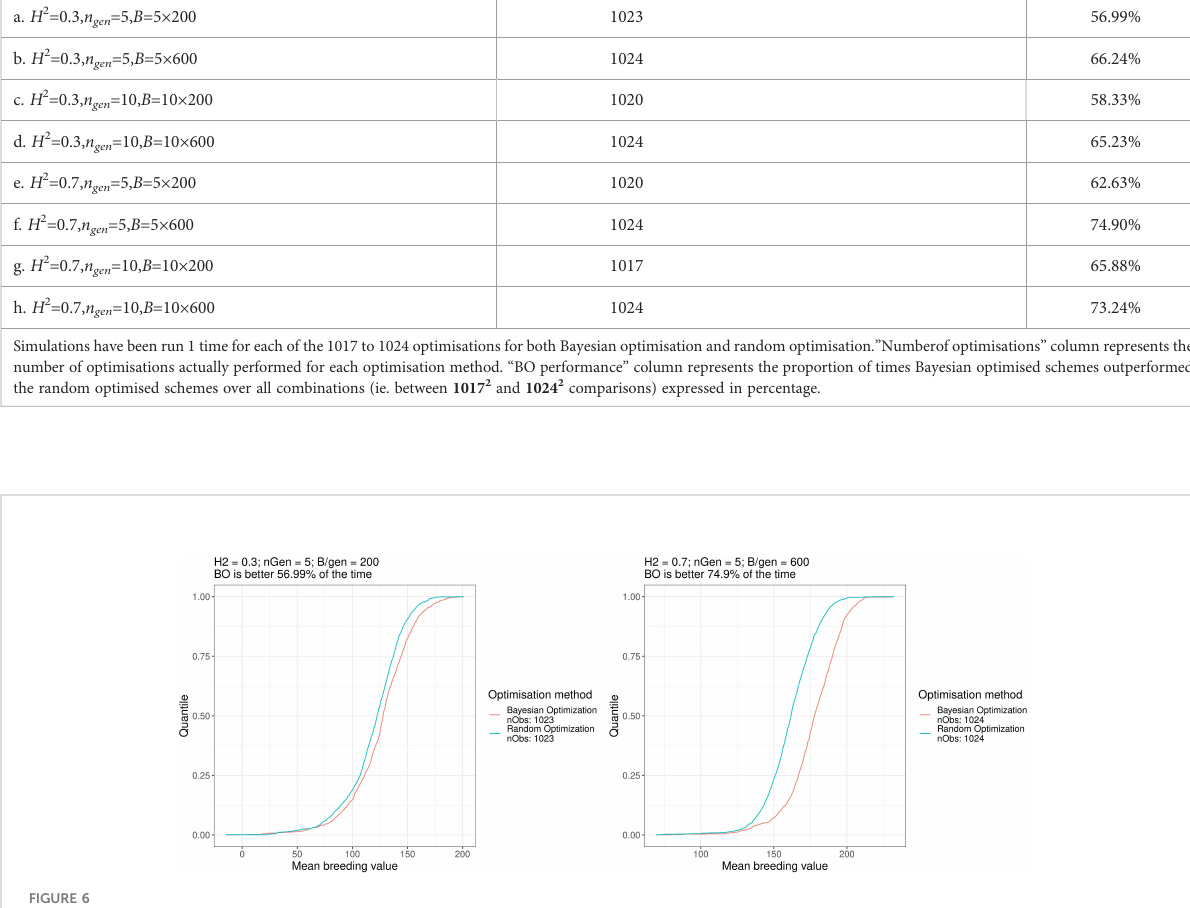
TABLE 2 Proportion of times Bayesian optimised schemes outperformed random optimised schemes for all scenarios. Scenario